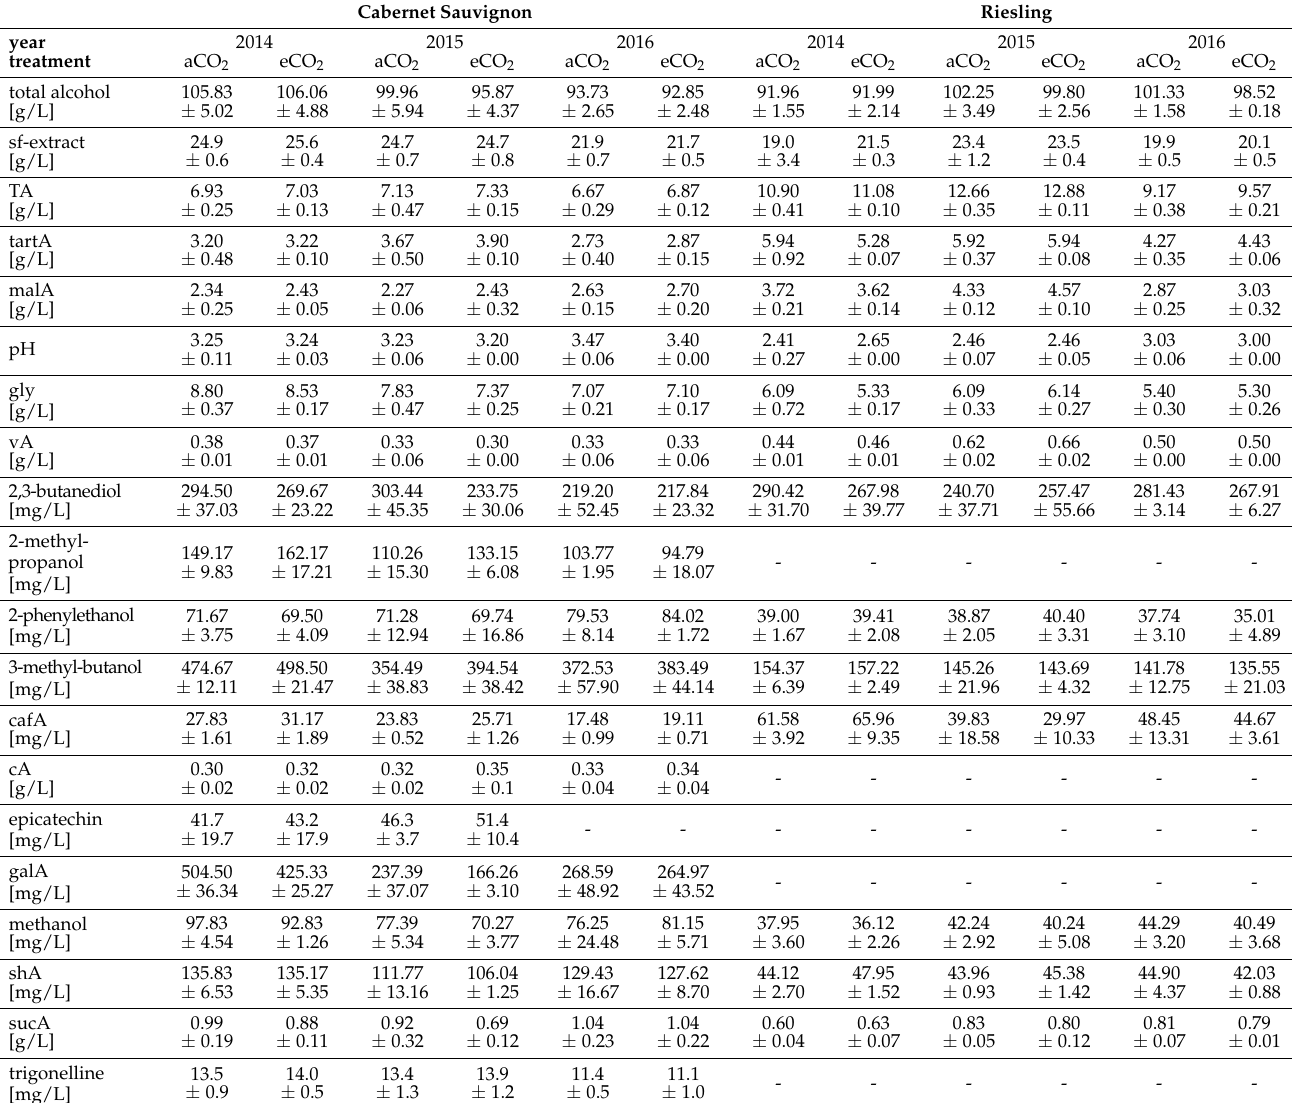
Table 3. Results of cvs. Cabernet Sauvignon and Riesling wine analysis at two CO 2 levels (aCO 2 and eCO 2 ) after fermentation of vintages 2014, 2015 and